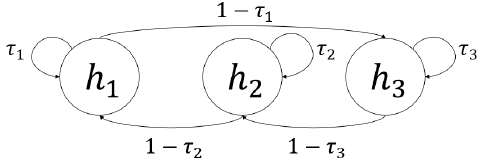
Figure 1. Schematic description of the Markov chain.